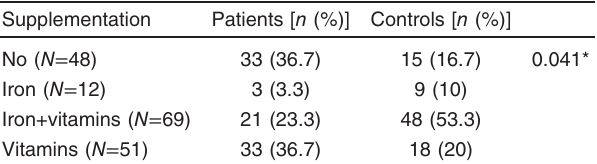
Table 2 Comparison between patients and controls regarding the type of supplementation (total N =